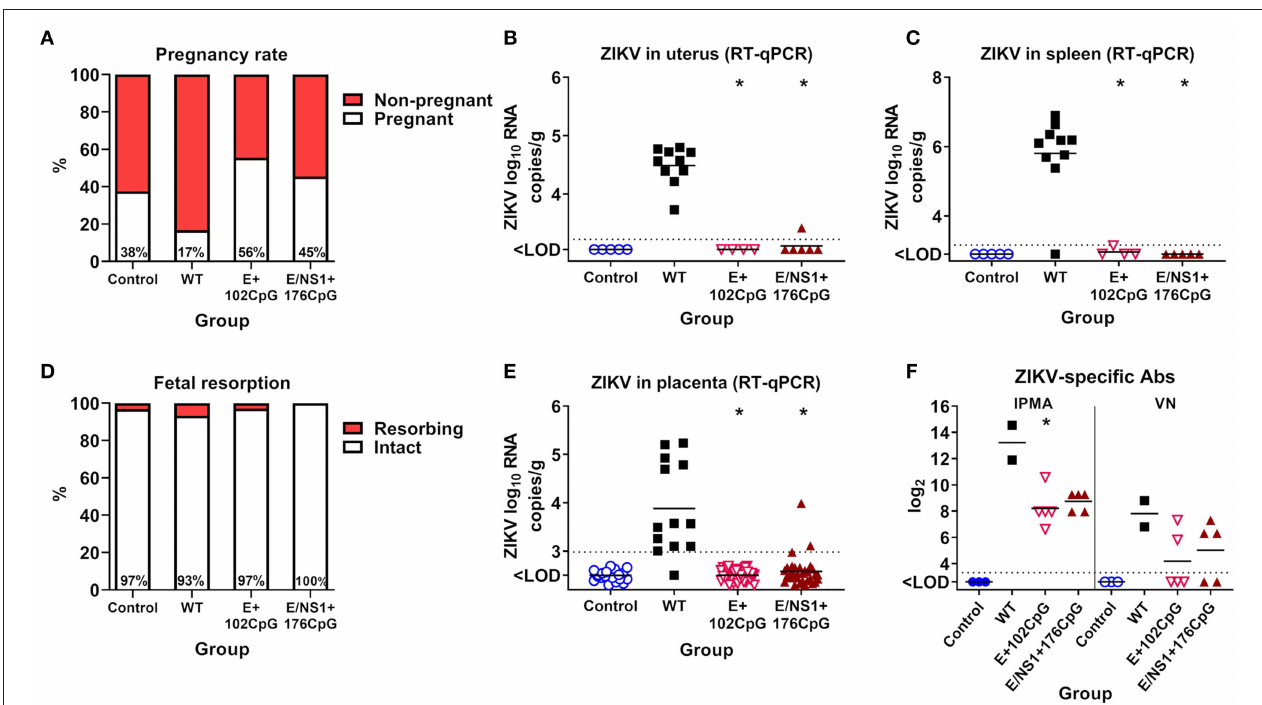
FIGURE 7 | Infection phenotypes of CpG-recoded ZIKV variants in pregnant mice. (A) The pregnancy rate in mated and plugged mice ( n = 8 dams, Control; n = 12, WT; n = 9, E + 102CpG; n = 11, E/NS1 + 176CpG). ZIKV loads in the uterus (B) and spleen (C) of bred, non-pregnant mice. (D) The percentage of fetal resorption ( n = 32 fetuses, Control; n = 15, WT; n = 35, E + 102CpG; n = 33, E/NS1 + 176CpG). (E) ZIKV loads in the placenta. (F) Maternal ZIKV-specific IgG (quantified by immunoperoxidase monolayer assay—IPMA) and neutralizing (quantified by virus-neutralizing assay—VN) Abs in the pregnant subgroup. Asterisk (*) denotes a statistically significant difference compared to the WT ZIKV group. Dotted lines represent the LOD, solid lines represent mean